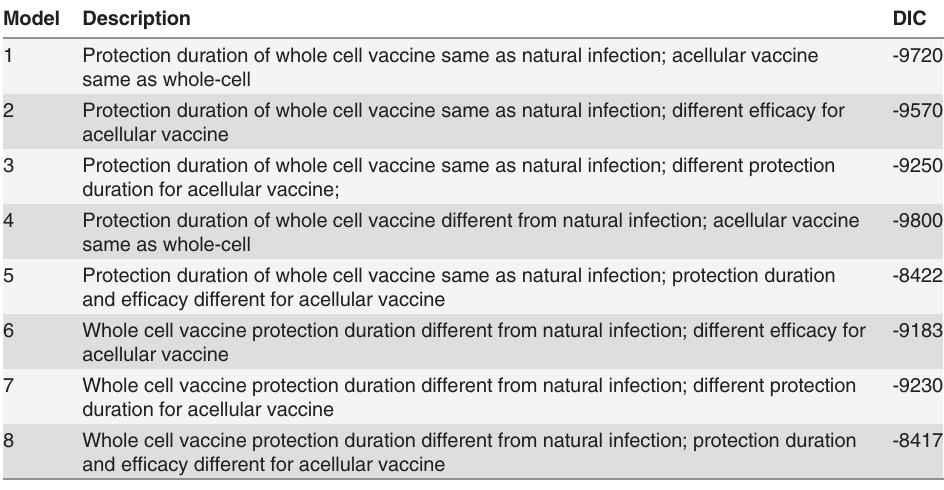
Table 1. Descriptions of the nested models that were fitted to the NNDSS incidence data.